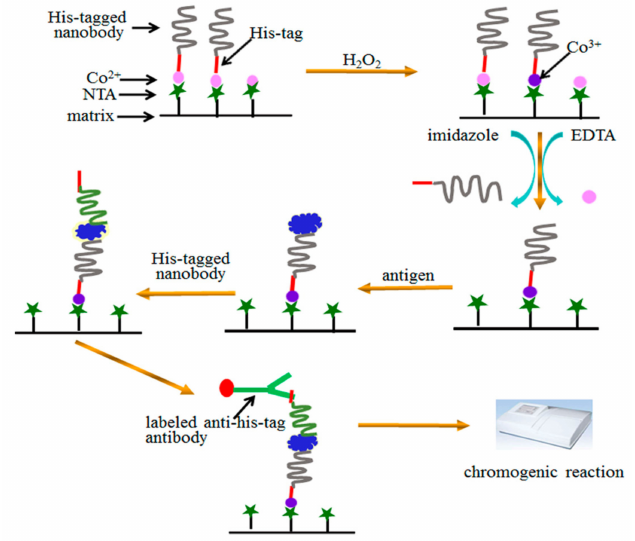
Figure 5. A scheme for oriented immobilization and quantitative analysis in sandwich immunoassay via His-tagged